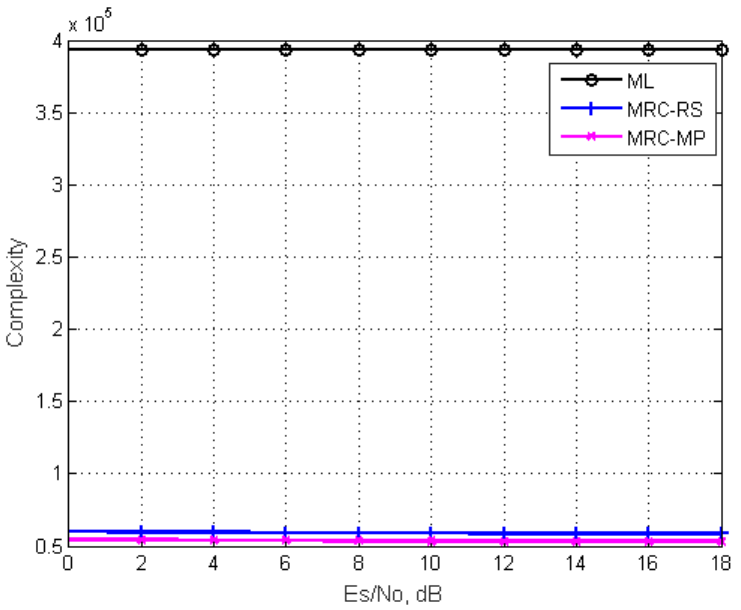
Figure 7. Comparison of the computational complexity of the proposed detectors and ML detectors for a GSM system with